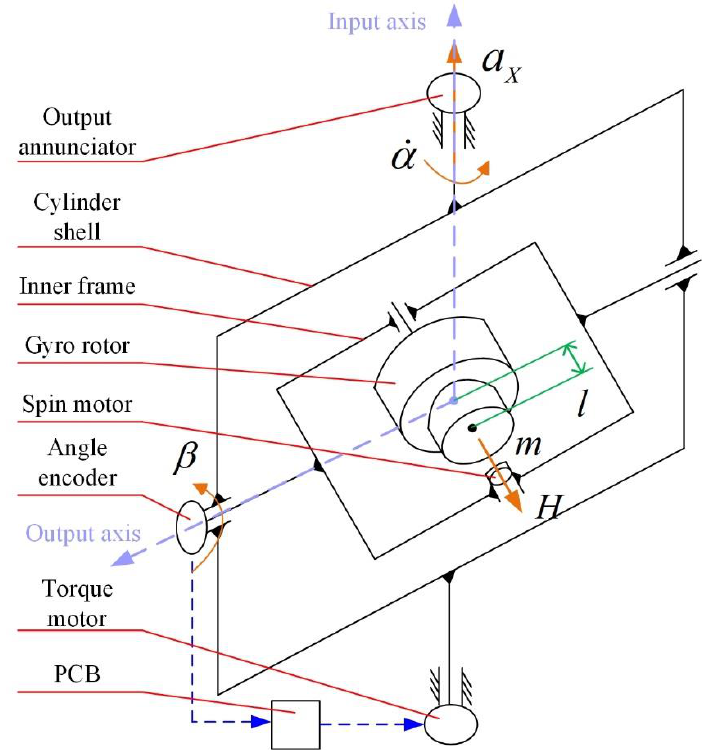
Figure 2. Illustration of the working principle of PIGA. angular momentum of the gyro rotor is H . The mass of the pendulous mass in the gyro rotor is m , and the displacement between the center of the mass of the gyro rotor and the pendulous mass is l (the center of the mass of the gyro rotor coincides with the intersection of the axes of the cylinder shell and the inner frame). The acceleration a X along the input axis (the input axis coincides with the axis of the cylinder shell) causes the corresponding torque mla X on the gyro rotor around the output axis (the output axis coincides with the axis of the inner frame) to cause precession motion of the cylinder shell around the input axis. The output annunciator is used to measure the precession angular rate cylinder